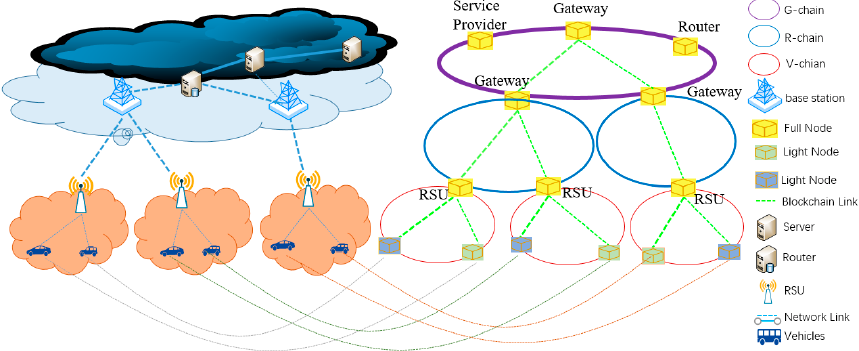
Figure 2. Hierarchical organization of blockchains in Ba-ITS.